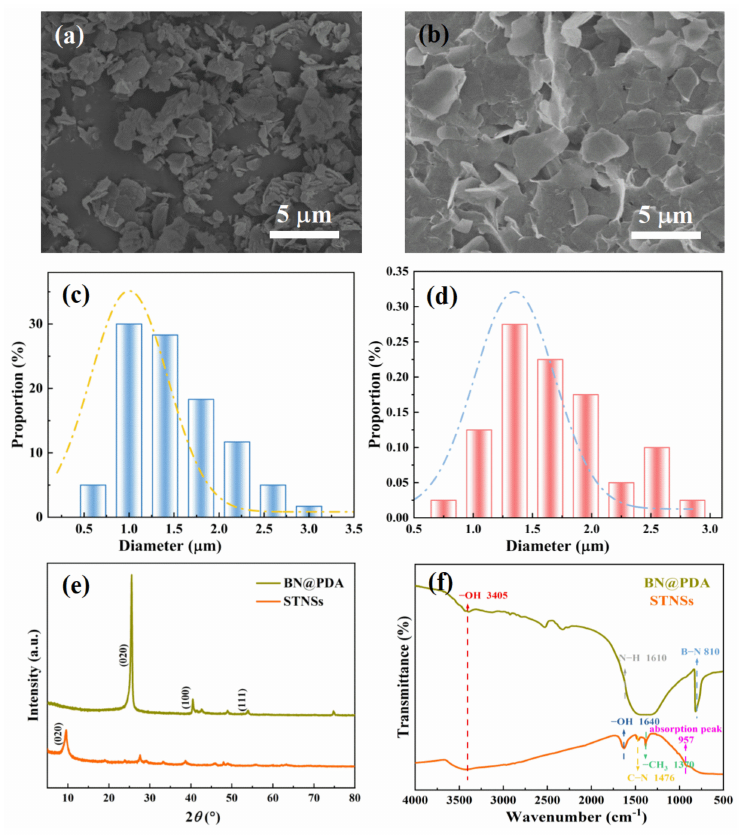
Figure 1. The SEM images of ( a ) BN@PDA and ( b ) STNSs. The diameter distribution of ( c ) BN@PDA and ( d ) STNSs. ( e ) The XRD patterns and ( f ) FTIR spectra of BN@PDA and